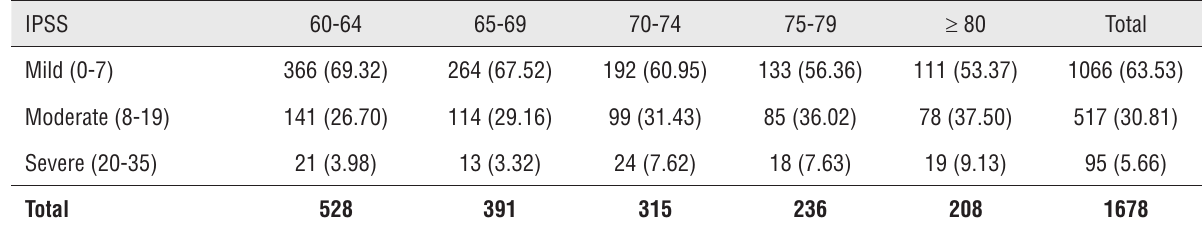
Table 2 - Result of IPSS in